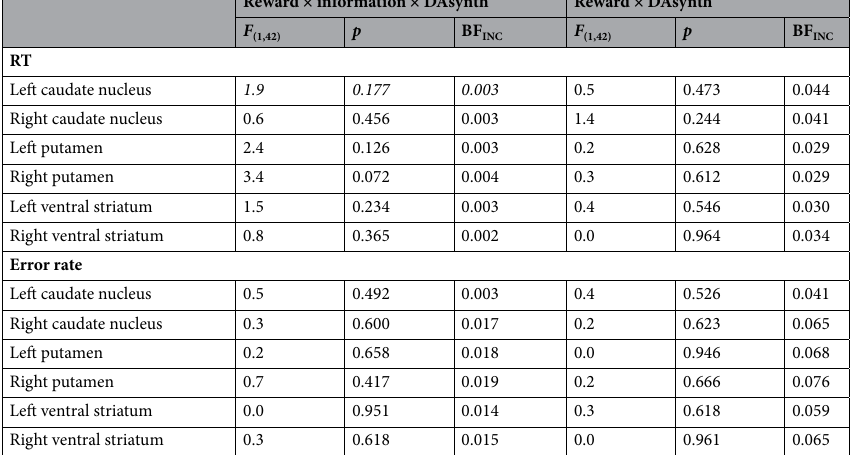
Table 2. Interaction effects in terms of response times (RT) and error rates obtained from the rmANOVAs with dopamine synthesis capacity in each ROI as a single covariate. Note that Aarts et al. analyzed the interaction between congruency, reward, information and dopamine synthesis capacity on response times and error rates. Here, we show the equivalent interaction between reward, information and dopamine synthesis capacity on Stroop interference (i.e. the difference between incongruent and congruent trials). The dependent variable is Stroop performance (mean RT or error rate on incongruent trials minus mean RT or error rate on congruent trials). Values in italic was the interaction observed in Aarts et al. to be significant. p -values below a Bonferroni-corrected alpha-value of 0.0042 were considered